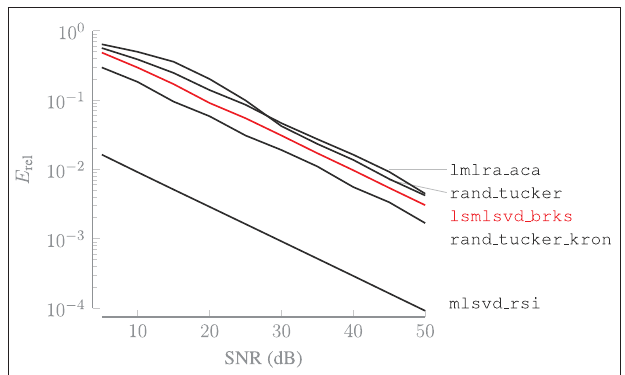
FIGURE 2 | Algorithm mlsvd_rsi is by far the most accurate because it used the full-sized matrix unfolding in the subspace iteration step. Algorithm lsmlsvd_brks is more accurate than lmlra_aca and rand_tucker and less accurate than rand_tucker_kron . If the sequential truncation step